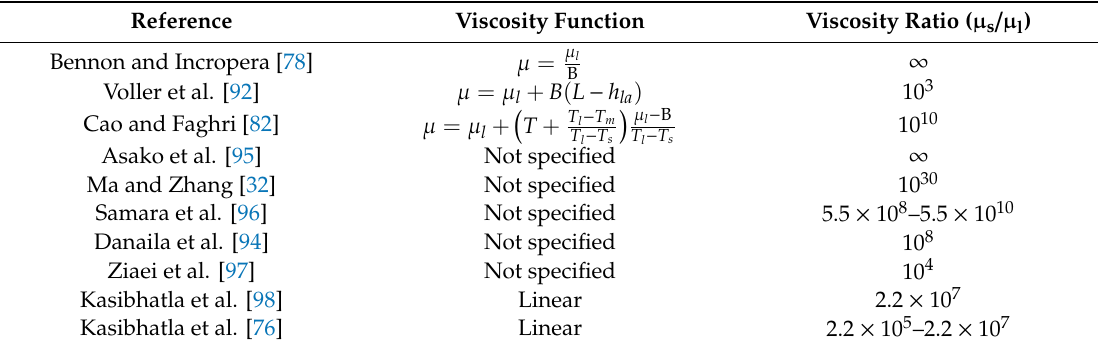
Table 2. Viscosity functions adopted in VVM